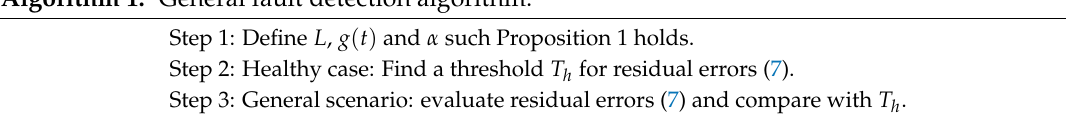
Algorithm 1: General fault detection algorithm.